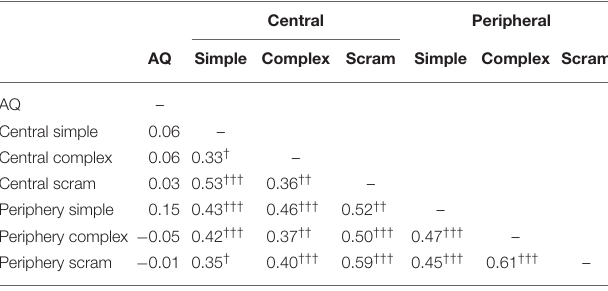
TABLE 3 | Kendall’s Tau correlations for AQ scores and perceptual reversion rates.